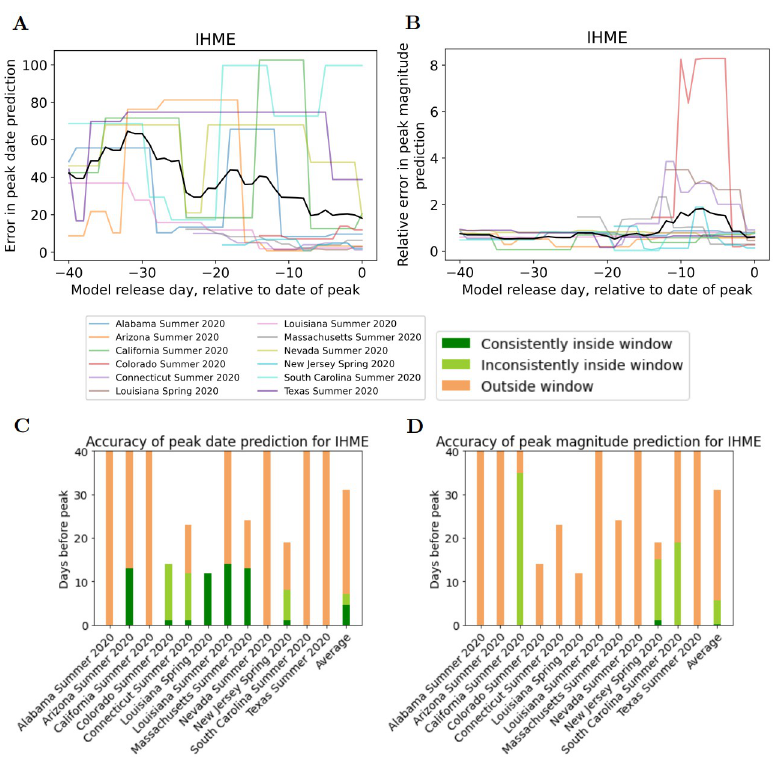
Fig 9. A) Errors in prediction of date of peak hospitalizations . B) Errors in prediction of magnitude of peak hospitalizations . Colored lines represent different peak events, black line is average across peak events. Lines that begin later than -40 begin on date of first model release. C) Visualization of predictive accuracy for date of peak hospitalizations of all Spring and Summer 2020 hospitalization peak events (see Table 2). D) Visualization of predictive accuracy for magnitude of peak hospitalizations of all Spring and Summer 2020 hospitalization peak events (see Table 2). Each bar represents a peak event. Dark green region represents the days prior to peak that the model accurately and consistently predicted date of peak (see definition of PeakDate_FirstConsistent score). Orange/light green boundary represents first day model predicted date of peak (see definition of PeakDate_FirstAccurate score).